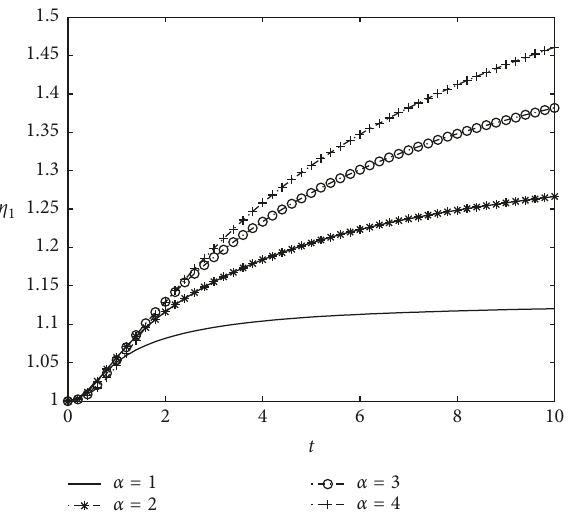
Figure 7: η over time for various values of α when applying the second nonlinear adaptive controller. 1